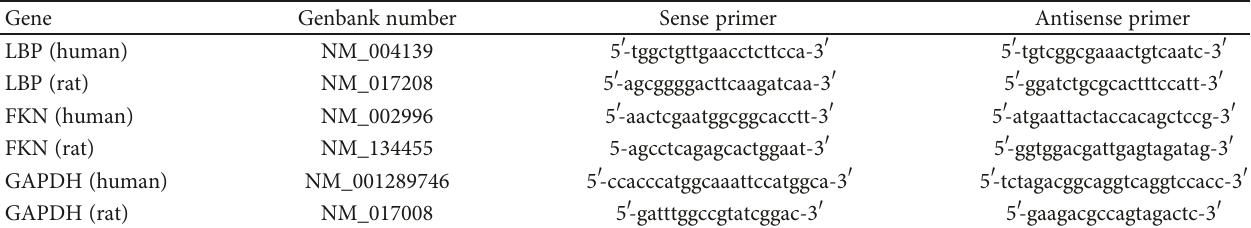
Table 1: The primer sequences and Genbank numbers for the primers